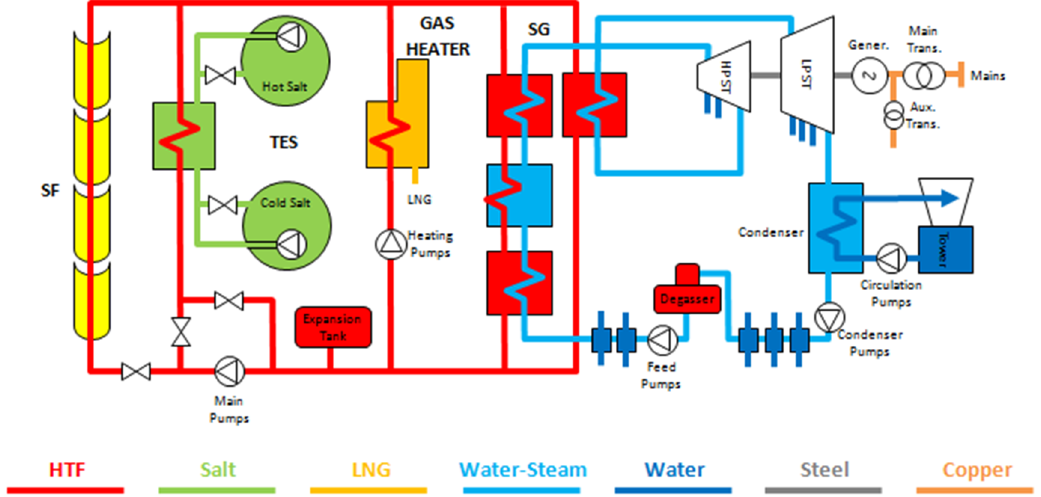
Figure 1. Schematic of a parabolic trough collector (PTC) solar thermoelectric plant.